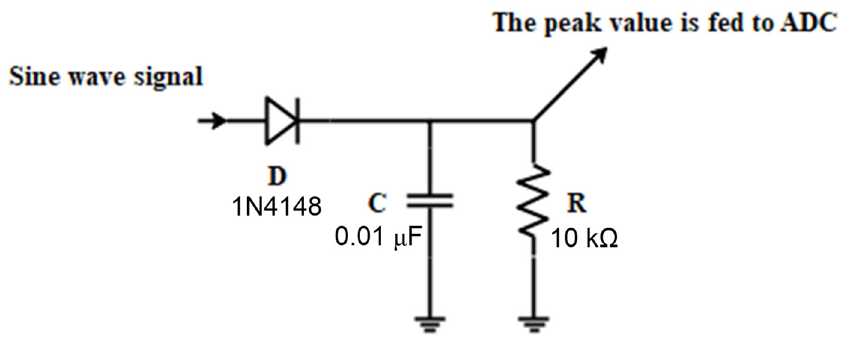
Figure 11. The peak detection